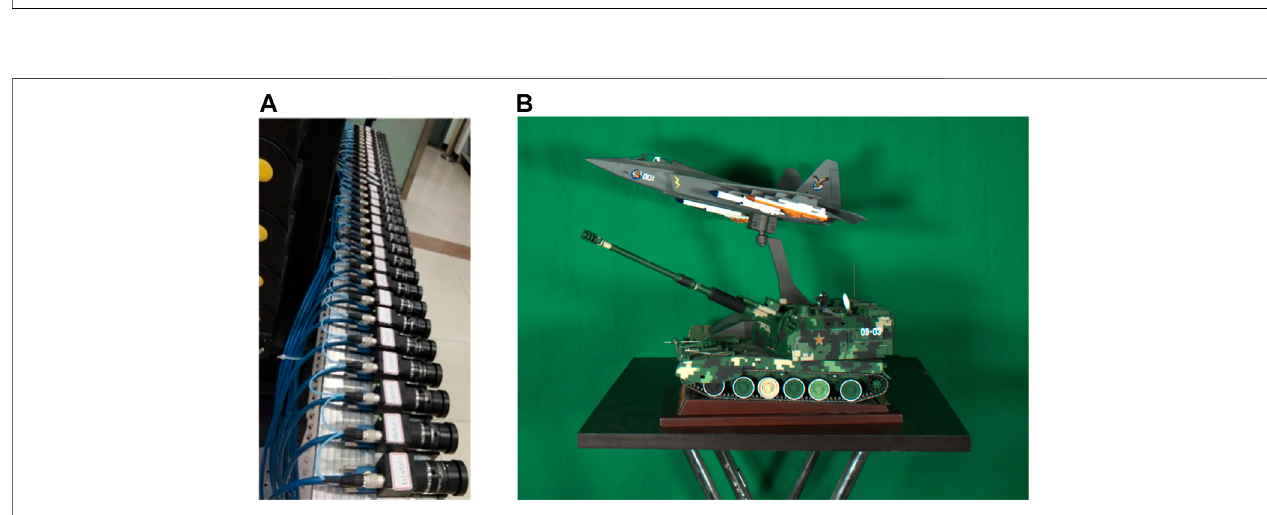
FIGURE 12 | The actual scene capture system, including (A) the camera array and (B) the models.